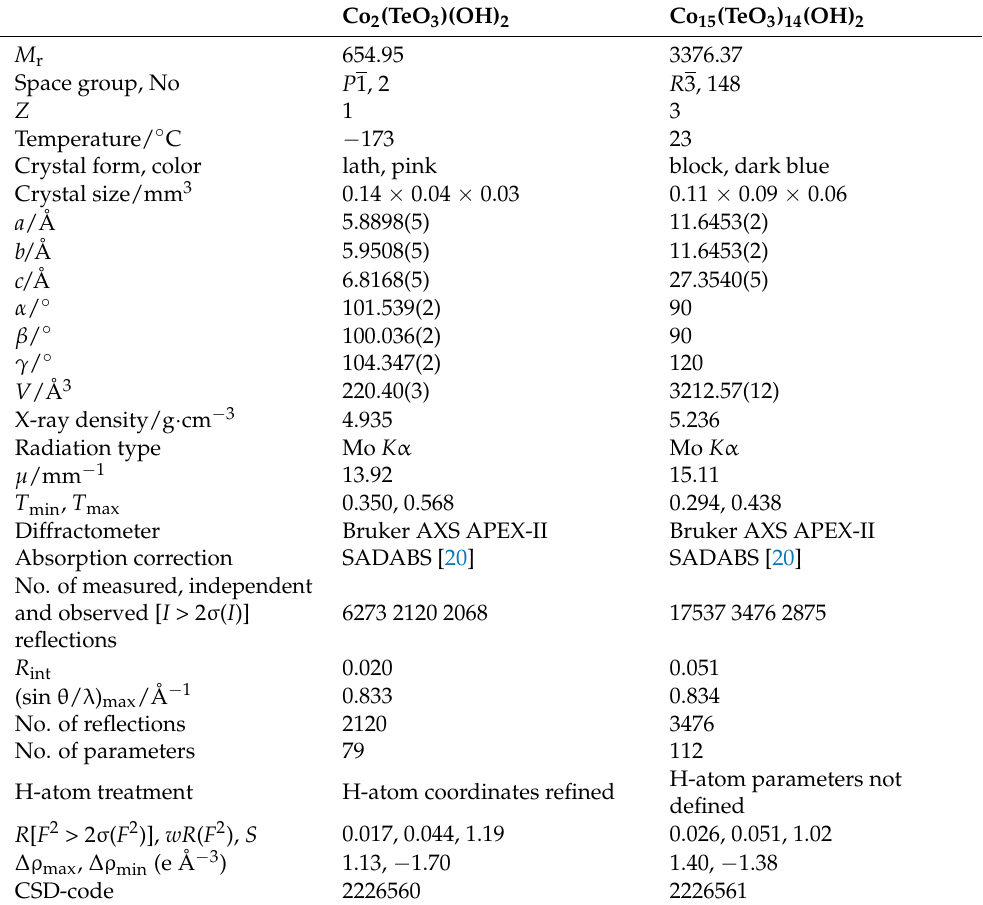
Table 1. Data collection and refinement